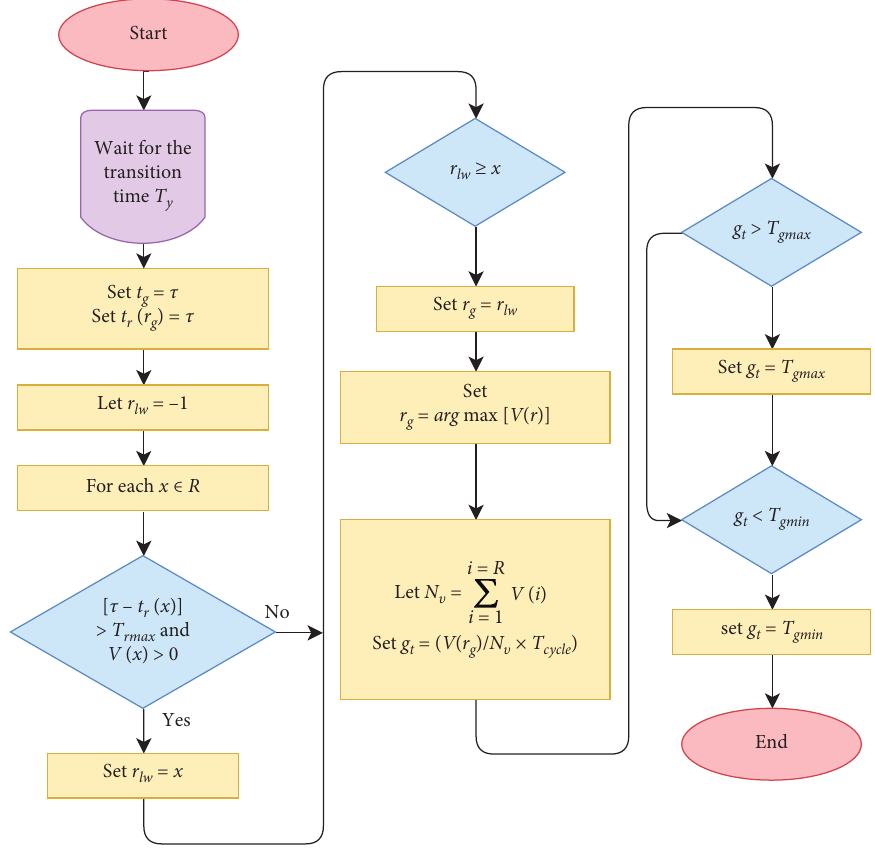
Figure 10: Flowchart for the process of selecting the next open